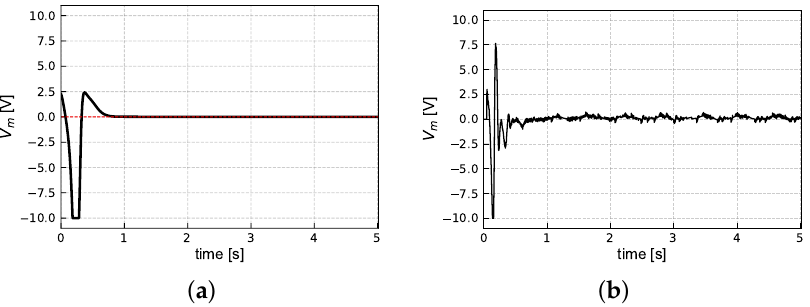
Figure 8. Case A2: Input signal: ( a ) simulation, ( b )